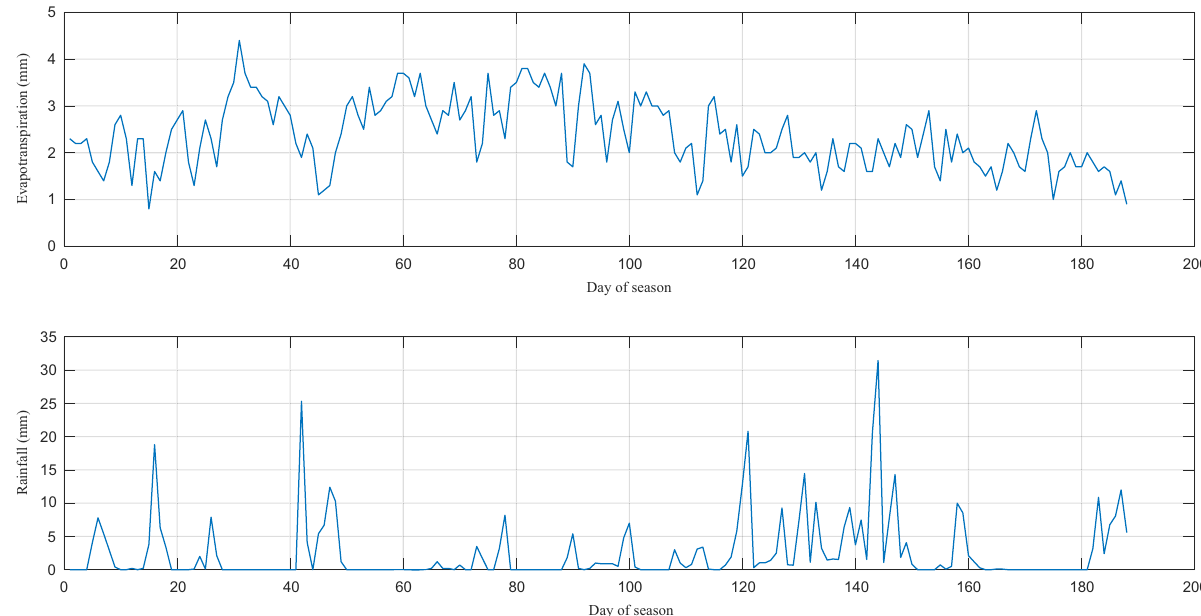
Figure 9: Precipitation and evapotranspiration in the Year 2017.